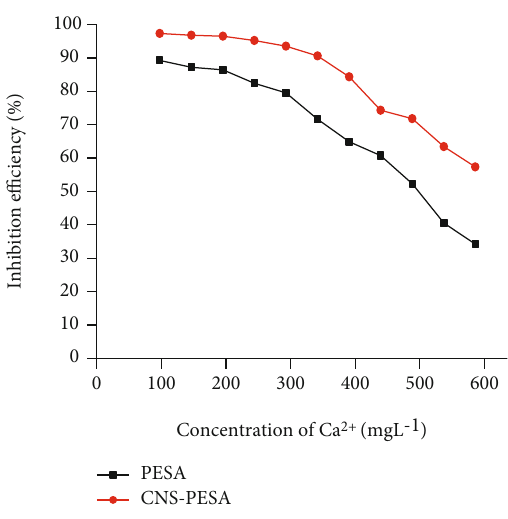
Figure 6: The e ff ect of calcium ion (Ca 2+ ) concentration on scale inhibition e ffi ciency of PESA and